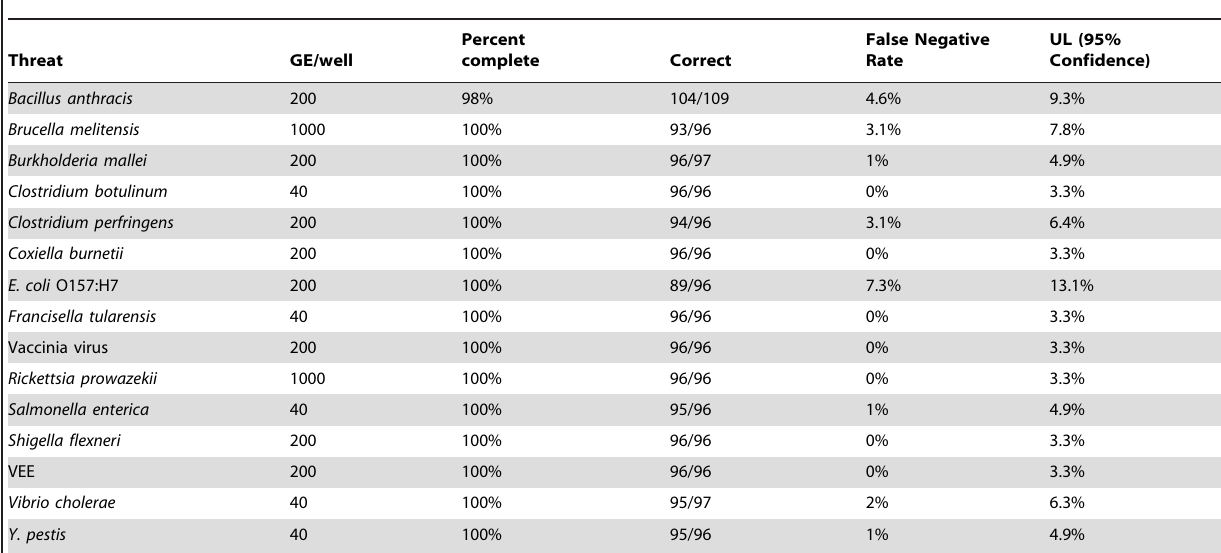
Table 3. Limits of detection and false negative rates.